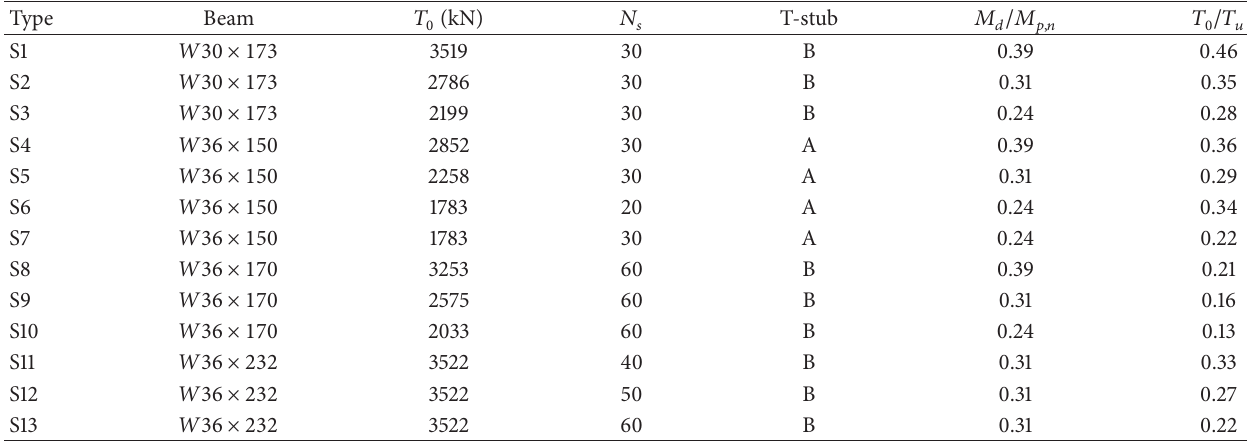
Table 4: Response of